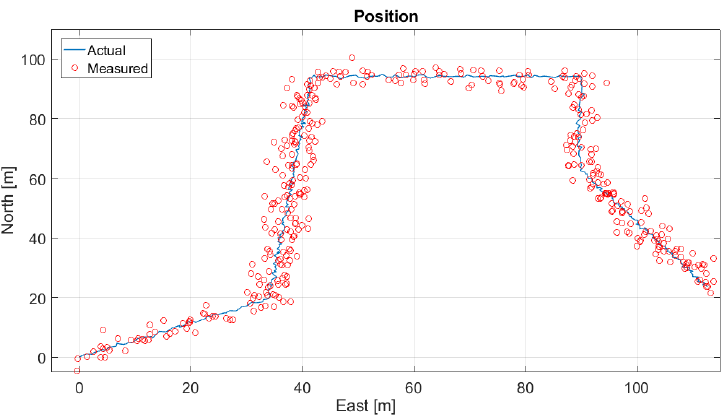
Fig. 4. Simulated route of a moving object, determined using the Kalman filter.